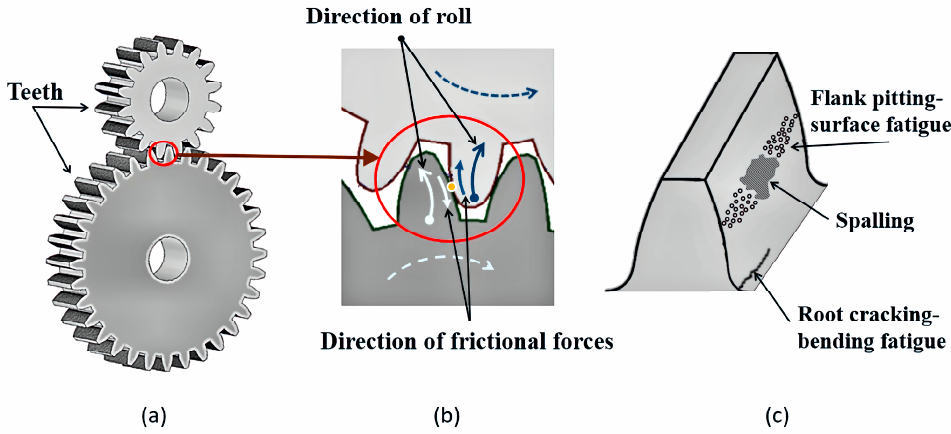
Figure 1. A typical gear drive mechanism: ( a ) Two gears in mesh; ( b ) Mechanics of gear tooth engagement (at point of first contact); ( c ) Gear tooth failures.